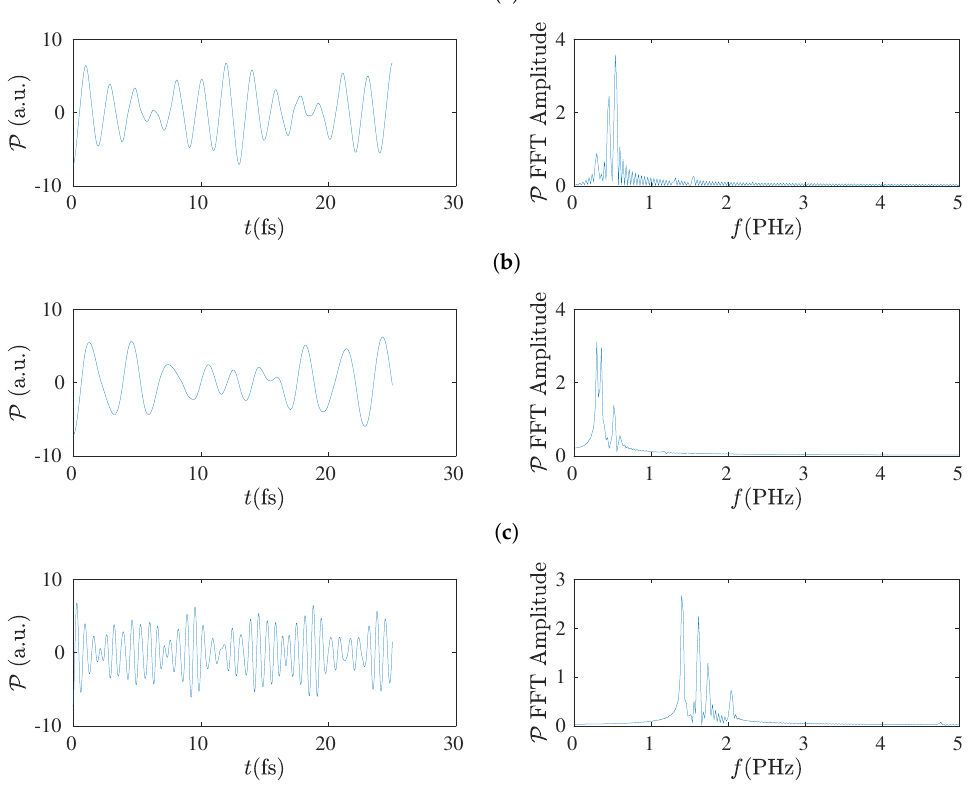
Figure 19. Left column: Dipole moment ( P ) oscillations obtained by the TB variants ( a ) TBI, ( b ) TBImod, ( c ) TBImodt4times, for N = 7. Right column: The corresponding FFT amplitudes obtained by MATLAB without any further